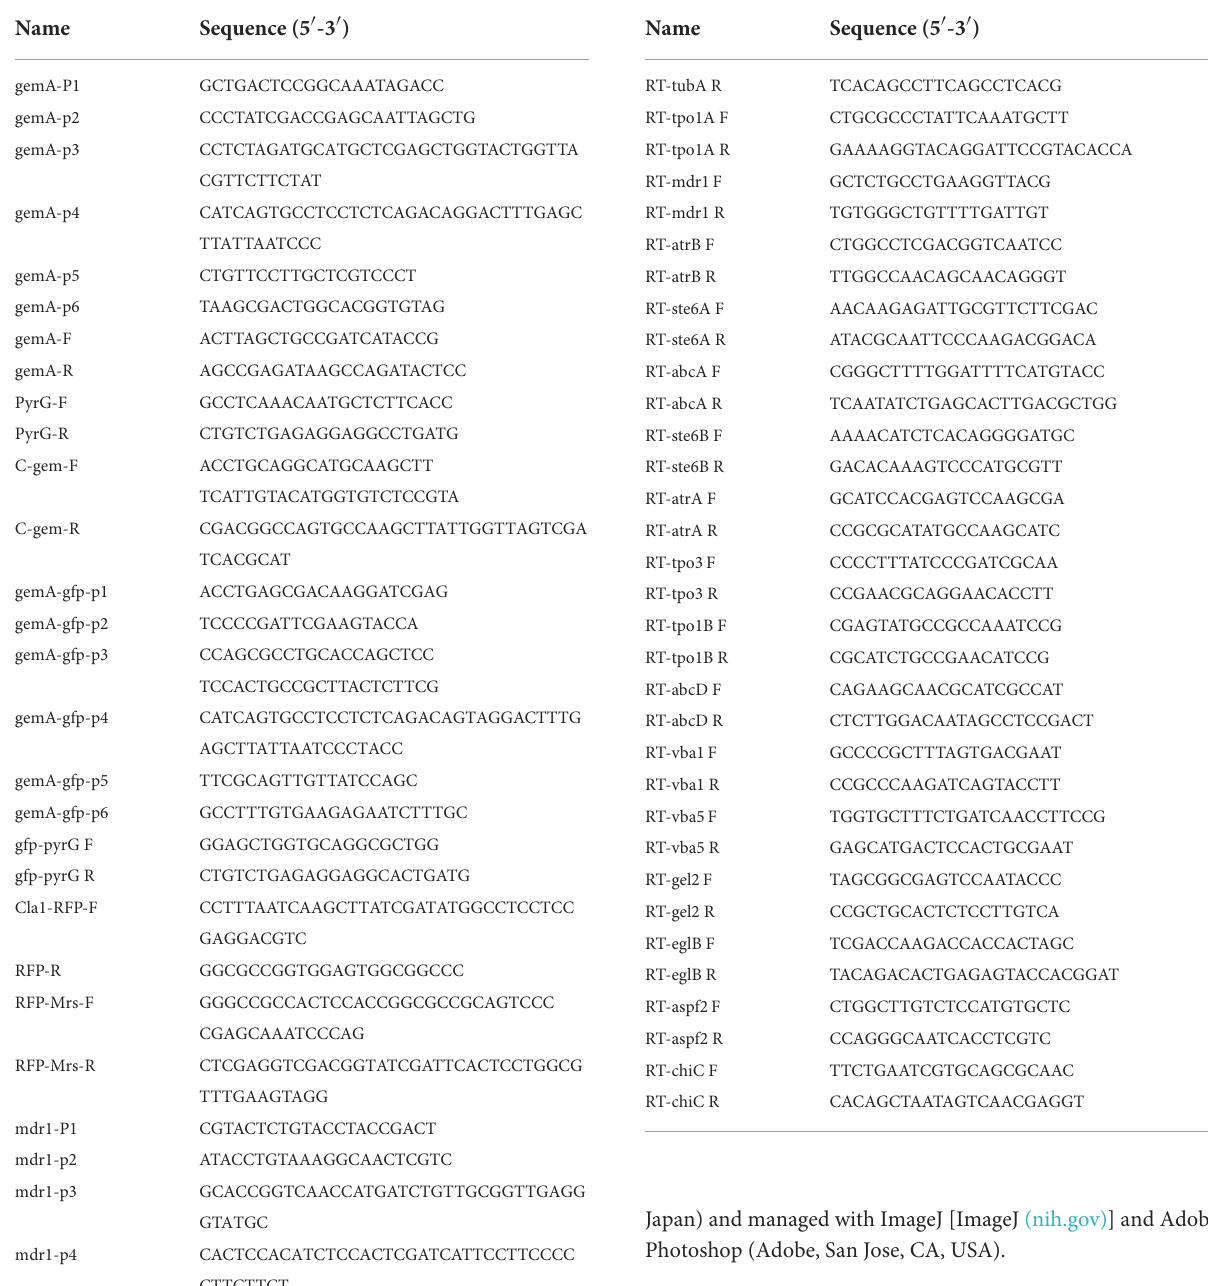
TABLE 2 Primers used in this